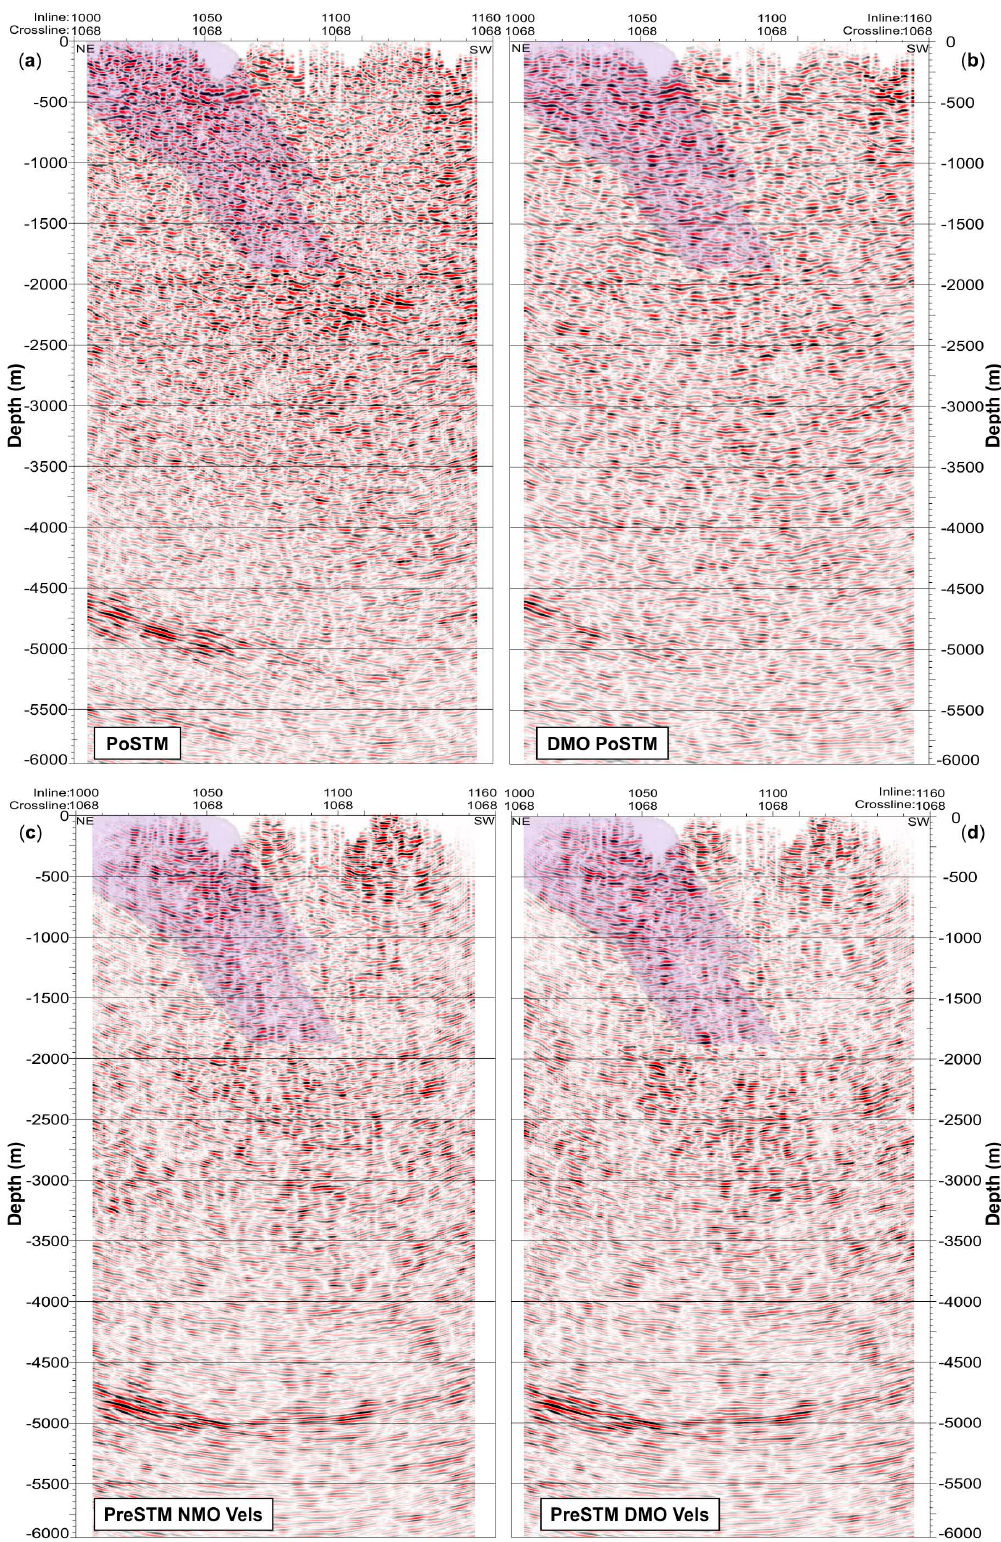
Figure 3. Comparison of various time imaging approaches for crossline 1068 running along the ore zone (see Figure 1 for location). ( a ) PoSTM, ( b ) DMO followed by PoSTM, ( c ) pre-stack time migration (PreSTM) with final normal moveout (NMO) velocities, ( d ) PreSTM with post-DMO velocities. The known extent of the Kylylahti formation as modelled using borehole constraints by Boliden is shown in